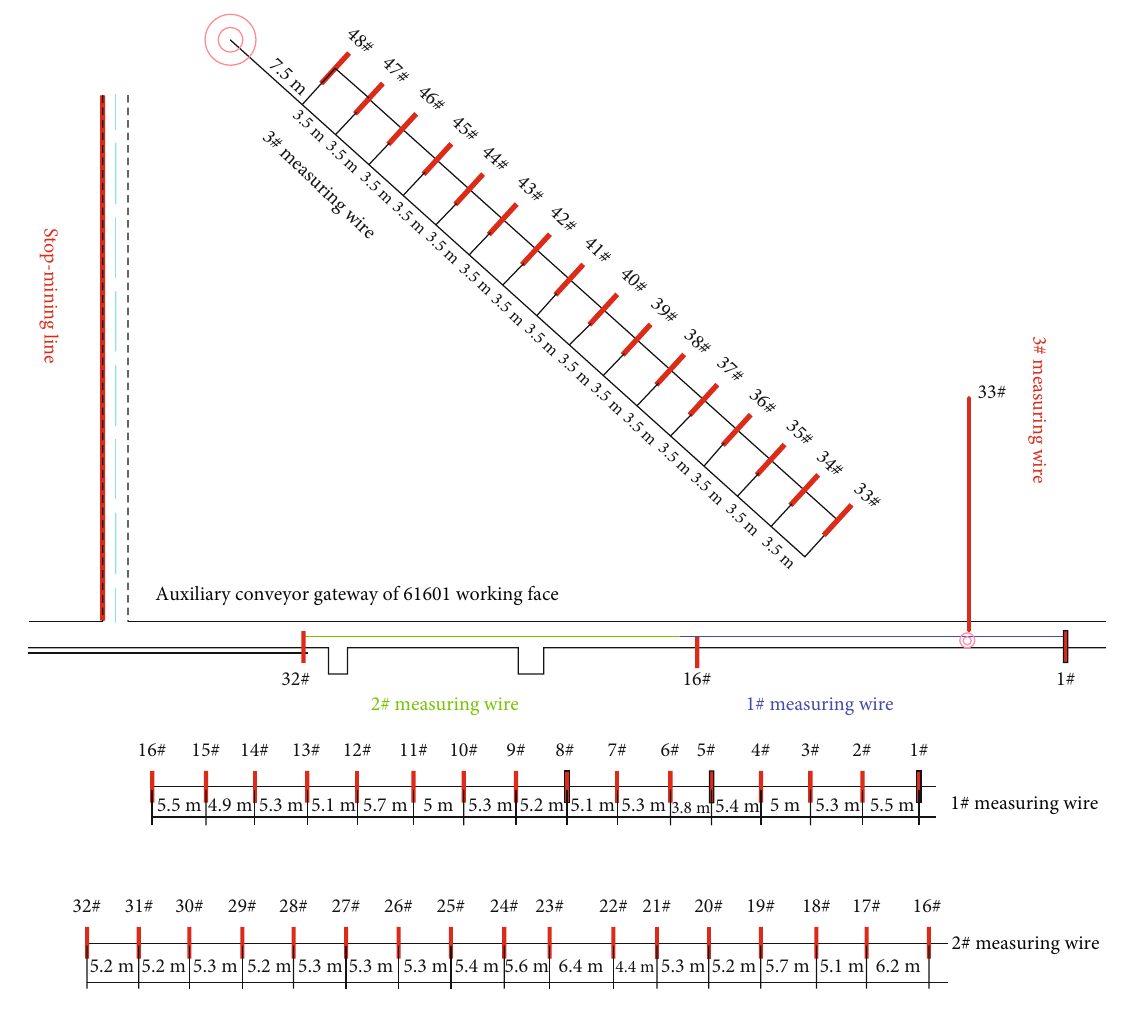
Figure 3: Layout of measuring wires and electrode positions.